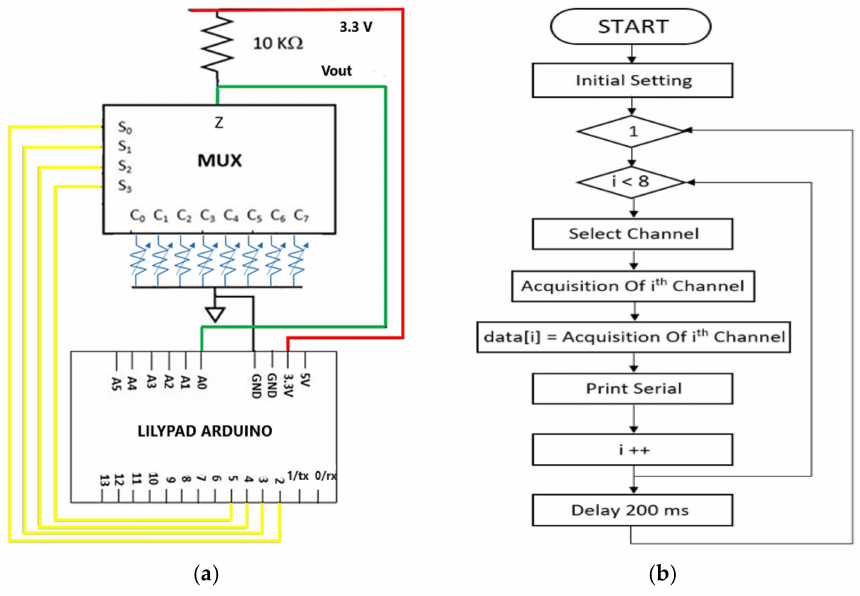
Figure 20. Schematic representation of the acquisition section of the signals related to the piezoresis- tive sensors of the developed piezoresistive matrix ( a ); flowchart of the Arduino board’s firmware for acquiring the resistance from the eight piezoresistive sensors ( b ).